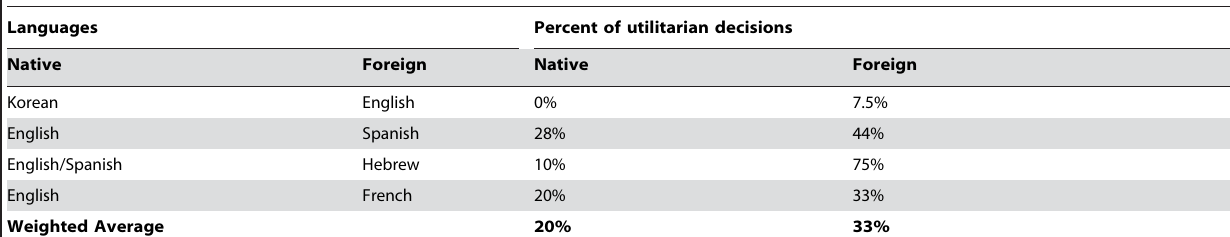
Table 2. Percentage of Utilitarian Decisions by Language Condition in Experiment